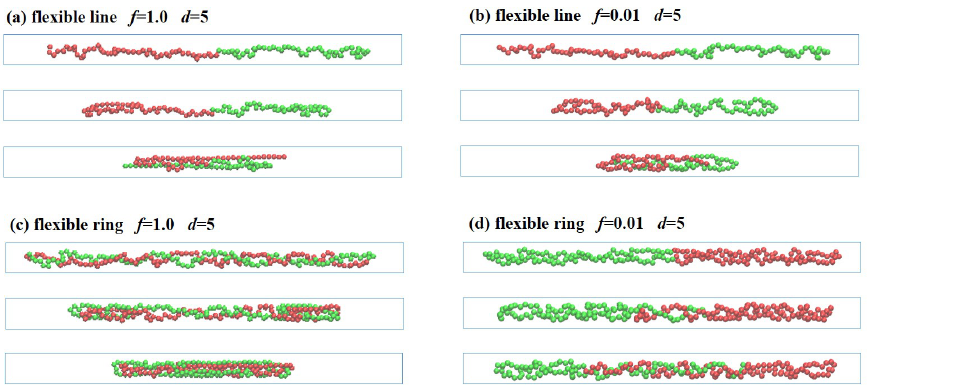
Figure 5. Compression of polymer chains in a confined channel with diameter d = 5: ( a ) flexible linear polymer under ( f / k B T = 1.0) with the end-to-end distance L x = 58.1,41.7,27.8 (from top to bottom), ( b ) flexible linear polymer under ( f / k B T = 0.01) with L x = 58.6,42.5,26.5, ( c ) flexible ring under ( f / k B T = 1.0) with L x = 64.4,41.3,29.1, and ( d ) flexible ring under ( f / k B T = 0.01) with L x = 64.2,53.8,54.6. The beads are labeled with red and green for